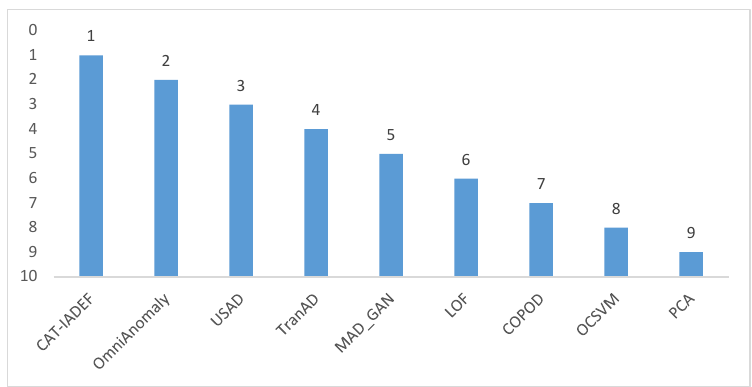
Figure 2. A comprehensive ranking of algorithm models.